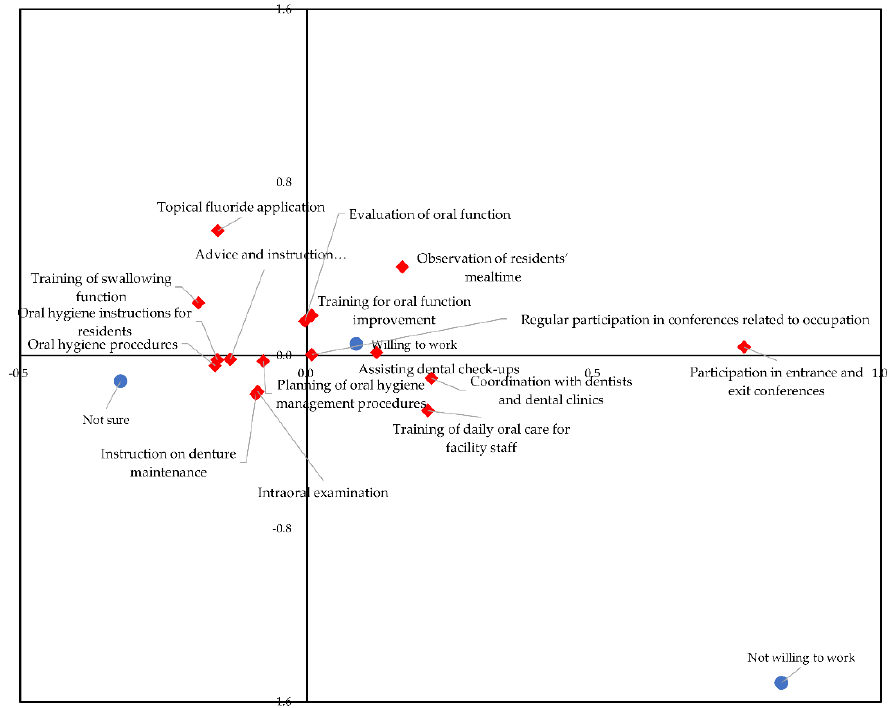
Figure 3. Biplots of willingness to work and daily tasks of dental hygienists at nursing facilities. Blue plots correspond to a willingness to work, and red plots correspond to daily tasks that dental hygienists performed in nursing facilities. Closely located plots are highly coincident.